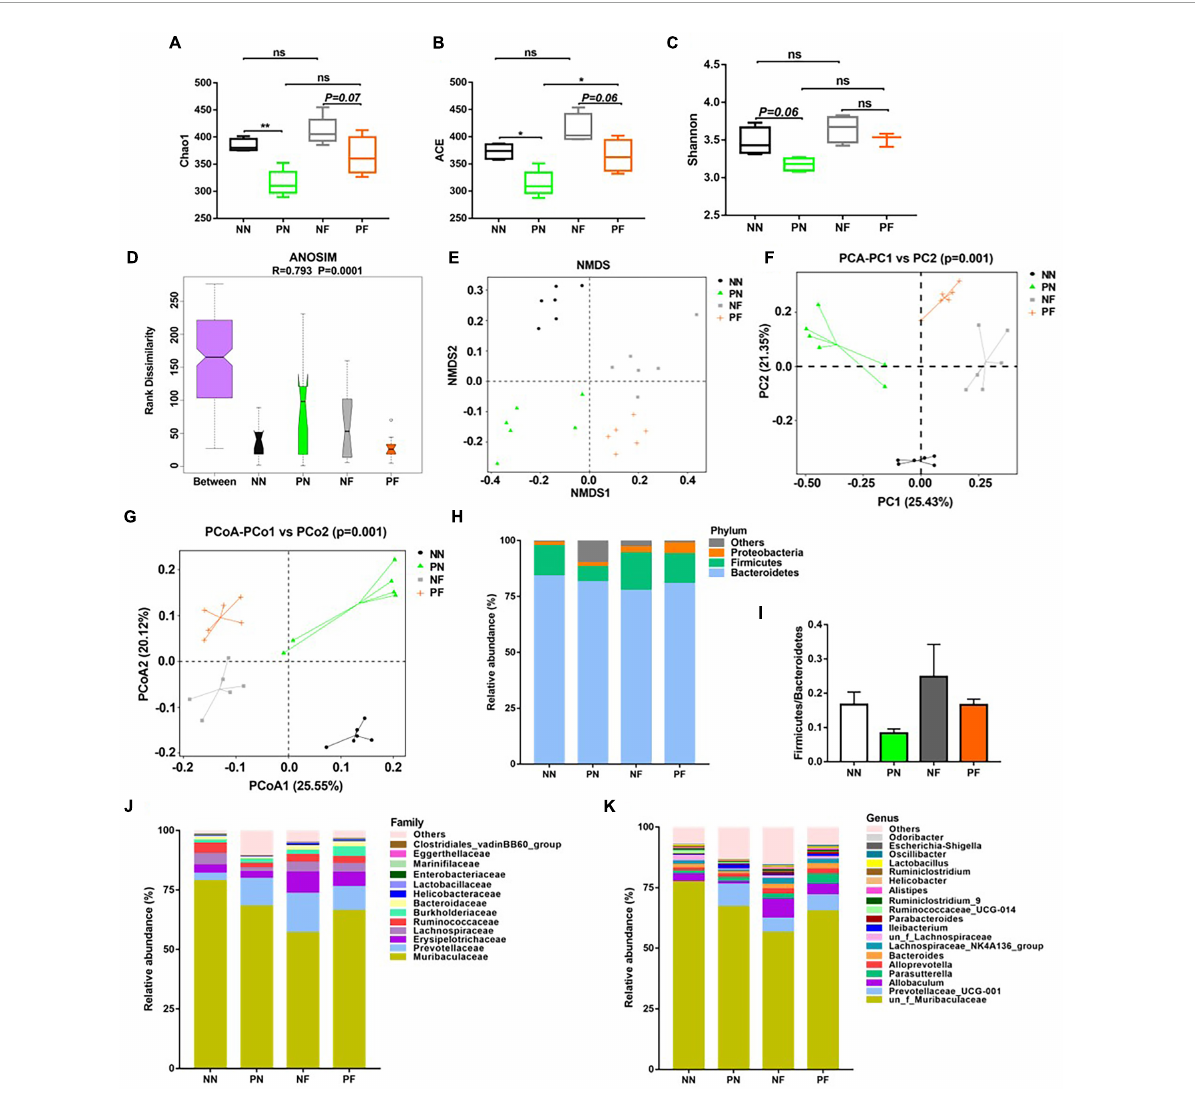
FIGURE4 Changes in the structure and composition of gut microbiota caused by light/dark phase shift and FMT. (A–C) Comparison of α -diversity indices including (A) chao1, (B) ACE, and (C) Shannon among groups. Data are expressed as mean ± 95% CI. Comparison among groups performed with One-way ANOVA. * P < 0.05; ** P < 0.01. (D) ANOSIM among groups ( R > 0, indicating a significant difference between groups). (E–G) Comparison of β diversity including (E) NMDS, (F) PCA analysis, and (G) PCoA analysis among groups. Each point represented a sample, and the points with the same color came from the same group. The closer the two points were, the smaller the difference in community structure was. The relative abundance of gut microbiota at the level of phylum (H) , family (J) , and genus (K) among groups. (I) The ratio of Firmicutes / Bacteroidetes among groups. NN vs. PN, NF vs. PF. n = 6 per group. NF, mice received FMT from the NN group; PF, mice received FMT from the PN group. NN, Non-phase shift; PN, Phase shift; ANOSIM, Analysis of similarities; NMDS, Non-Metric Multi-Dimensional